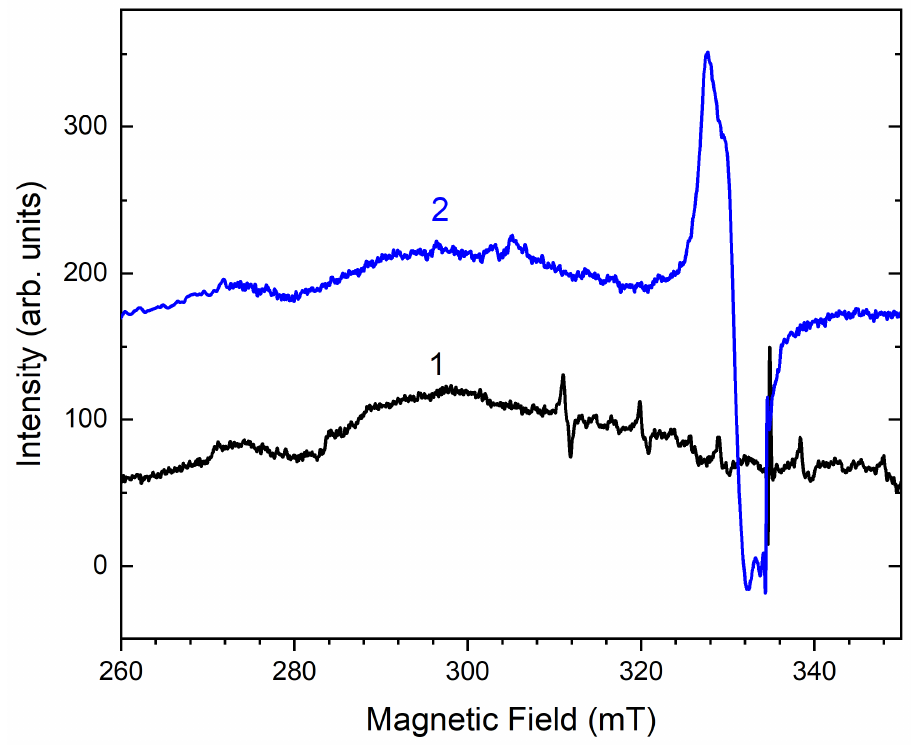
Figure 15. The ESR spectra of original haüyne (Sample 4) (1) and Sample 4 heated at 800 ◦ C (2). The black triangles show the bands of the S 6●− radical anions bands, and the vertical blue lines indicate the bands of S 3●− .